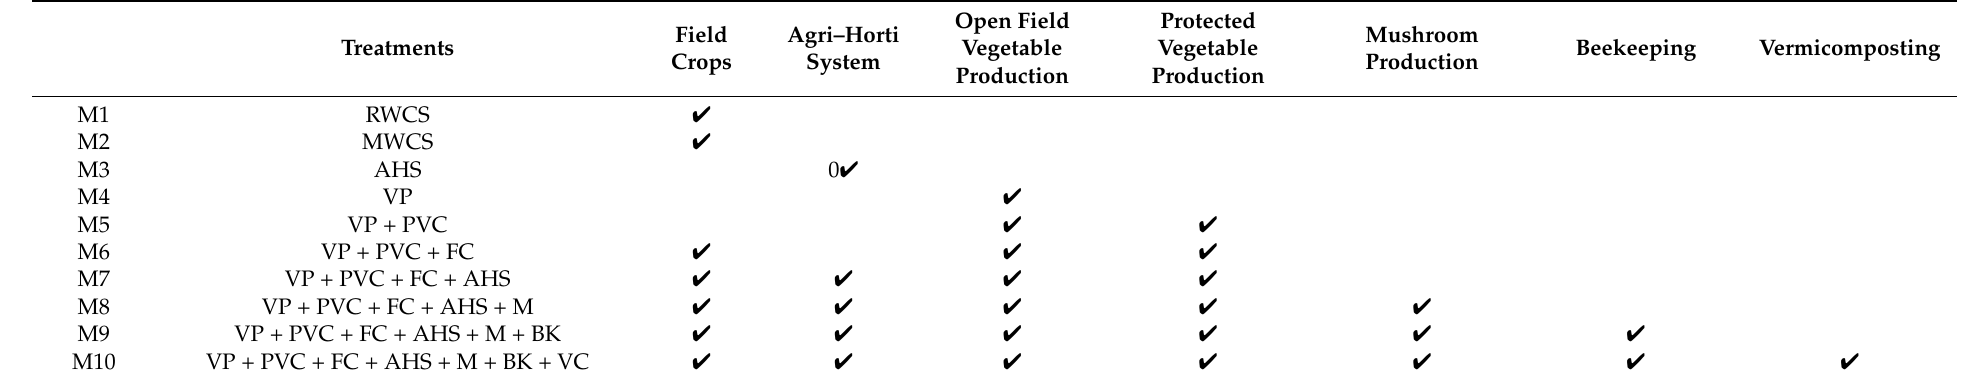
Table 1. Treatment details and components of various modules of the integrated farming system. Treatments